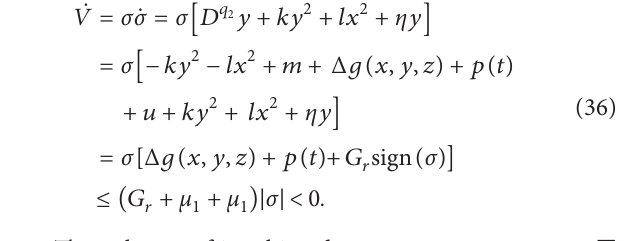
� q � 1 and fractional order: (a) q 1 2